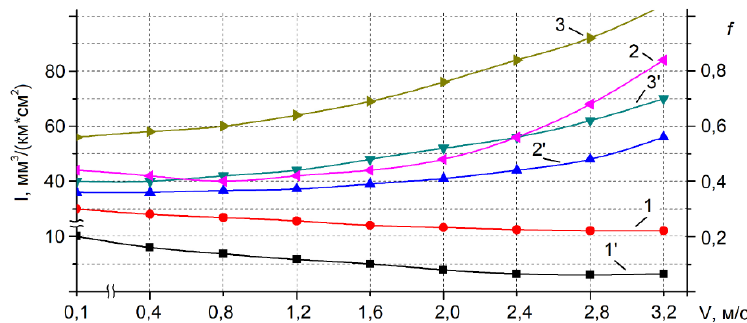
Fig.1. Dependence of wear intensity (1,2,3) and friction coefficient (1',2',3') on sliding speed of coatings SiC-Ni-